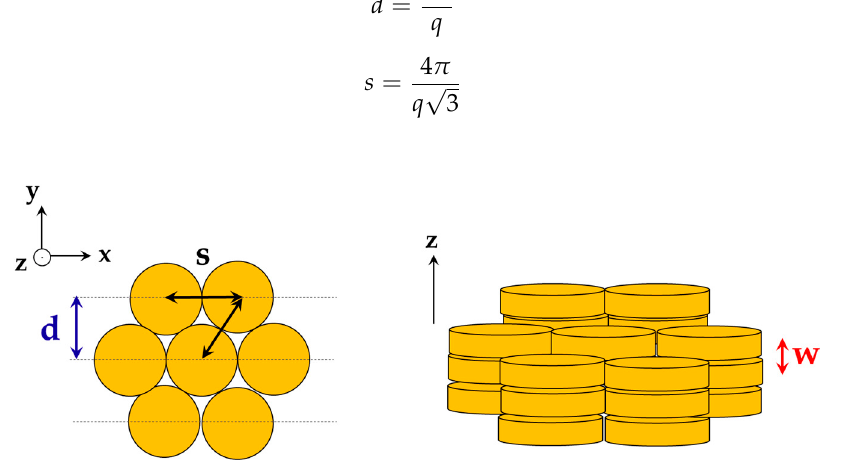
Figure 2. Definitions of the parameters d (lateral distance), s (neighboring columnar stacks), and w (stacking